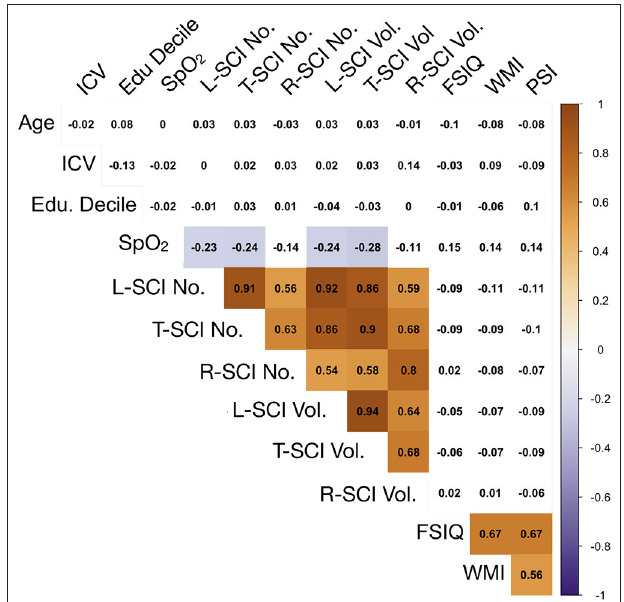
FIGURE 5 | Correlations between model predictors. Showing relationships between continuous variables included in the global regression models. Values are zero-order Spearman’s rank correlation coefficients. Shaded areas represent significant relationships (i.e., p < 0.05), with blue used to represent negative relationships, and orange used to represent positive relationships, and color intensity used to represent the strength of the relationships. ICV, intra-cranial volume; Edu. Decile, education decile; SpO 2 , peripheral oxygen saturation; SCI Lib, SCI liberal definition; SCI Trad., SCI traditional definition; SCI Rest, SCI Restrictive definition; No., Number; Vol, Volume; FSIQ, full-scale IQ; WMI, working memory index; PSI, processing speed index.